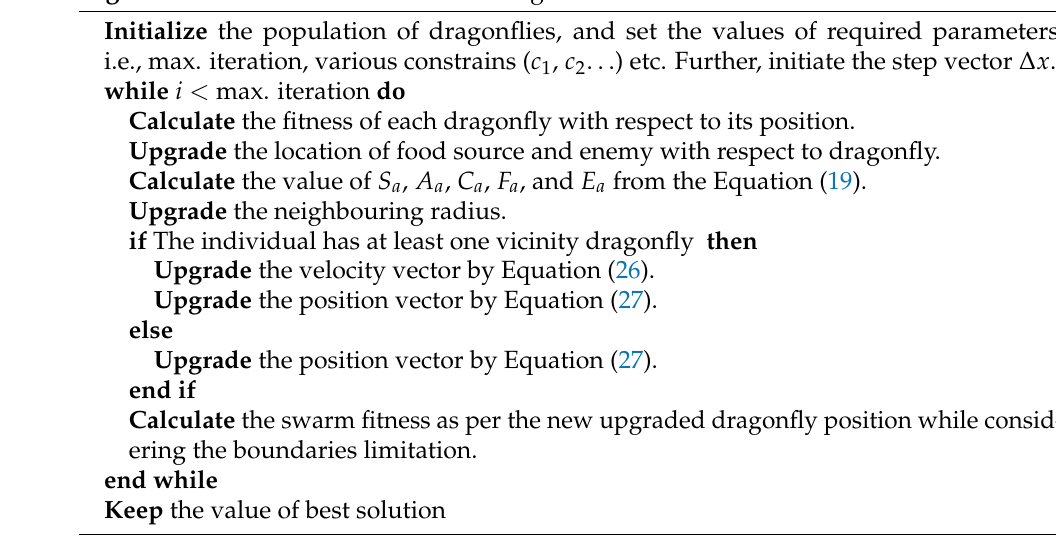
Algorithm 2 Pseudocode code for IDA